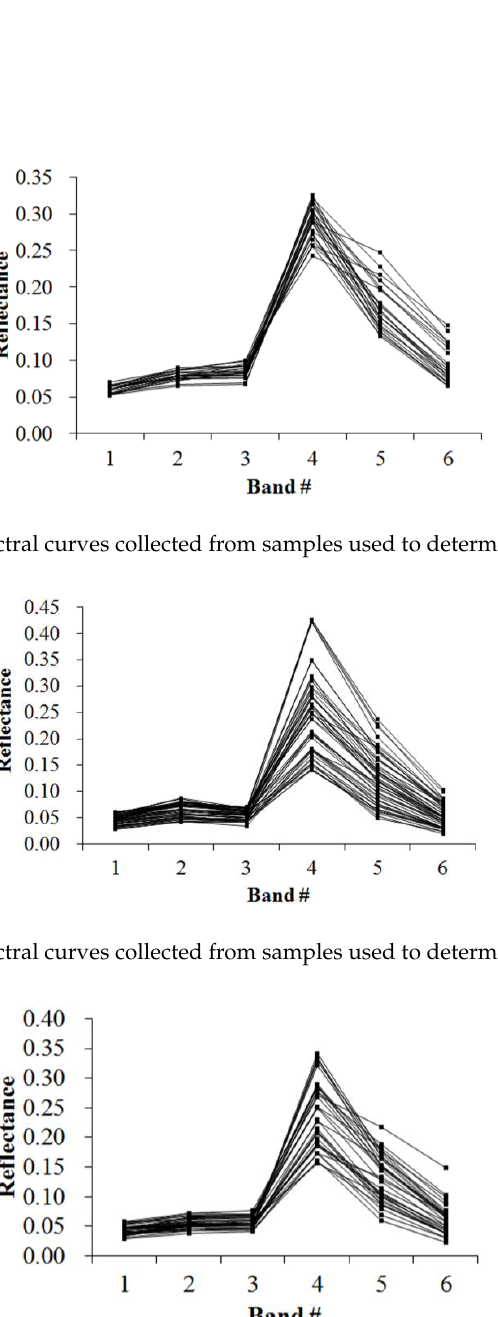
Figure 8. Spectral curves collected from samples used to determine Table 6. Table 6. Identification template 2 for forest class.